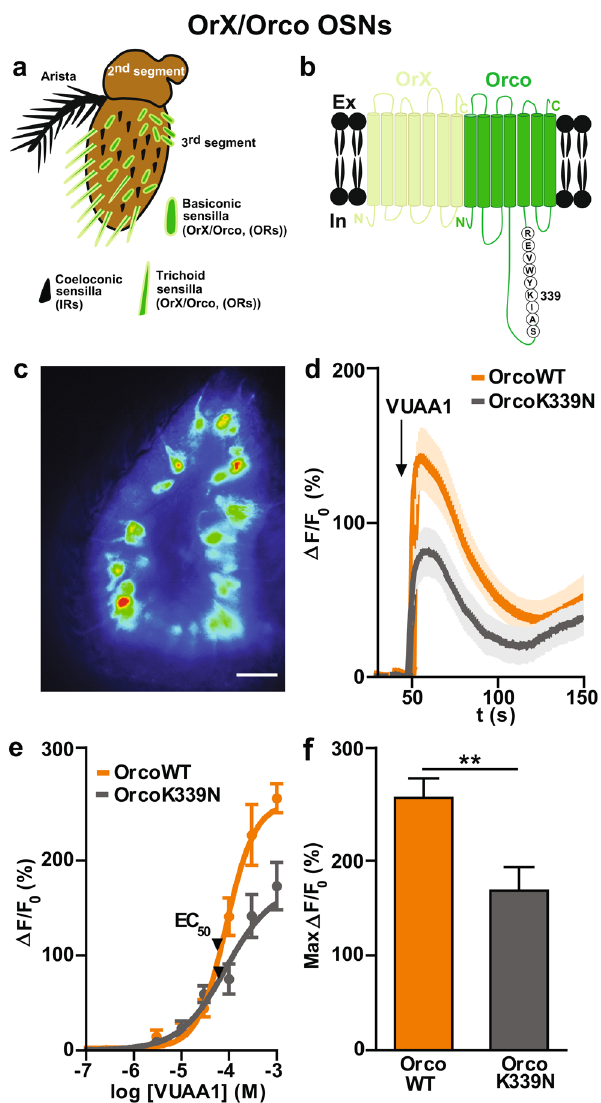
Figure 1. Effect of Orco CBS mutation on the odor response in OrX/Orco expressing OSNs. (a) Scheme of a Drosophila melanogaster antenna. The third segment is covered with sensilla that house the dendrites of up to four OSNs. OSNs that express ORs (odorant receptor) are present in basiconic and trichoid sensilla and coeloconic sensilla house IR expressing OSNs. (b) Schematic view of insect ORs formed by heptahelical OrX and Orco (co-receptor) proteins. The second intracellular loop of Orco contains the highly conserved CaM binding site 336 SAIKYWVER 344 . (c) GCaMP labelled fluorescence intensity of OrX/Orco expressing OSNs. (d) Time course of Ca 2+ fluorescence responses obtained in OrcoWT OSNs and OrcoK339N OSNs upon ORs stimulation with 100 µM VUAA1 (n = 10 for OrcoWT, n = 11 for OrcoK339N). (e) Concentration response relationship for OrcoWT and OrcoK339N (7 ≤ n ≤ 11). Curves represent sigmoidal fits described by Hill coefficient 1.44 (OrcoWT) and 0.89 (OrcoK339N), and EC 50 of 88 µM (OrcoWT), 85 µM (OrcoK339N). (f) Maximum fluorescence response (Max ∆F/F 0 (%)) obtained by subtracting the base level at 50 s from the maximum Ca 2+ fluorescence at 1 mM VUAA1. n = number of antennae. Two-tailed unpaired t- test , ** P < 0.01. Data given as mean ± SEM. Scale bar of antenna: 20